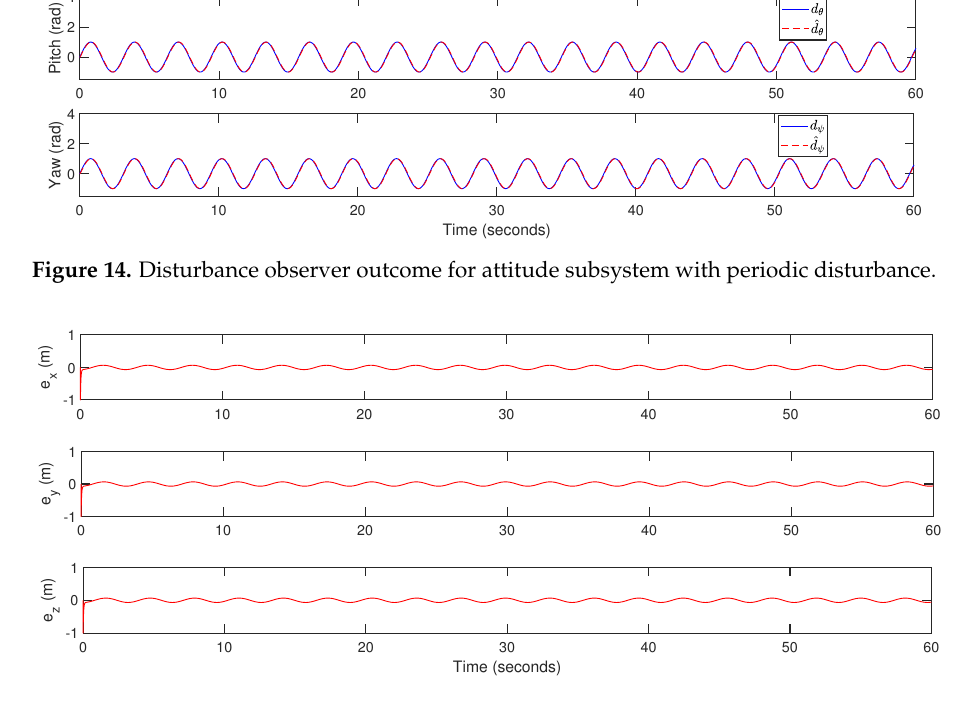
Figure 15. Estimation error of position subsystem when [1 + sin ( 2 t ) 1 + sin ( 2 t ) 1 + sin ( 2 t ) ] applied to position subsystem.